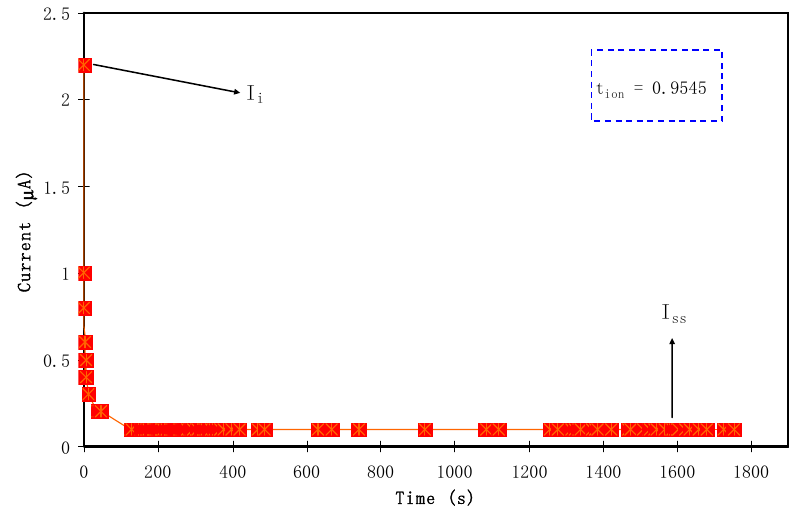
Figure 4. Current with respect to time plot for theCSPX4 blend electrolyte film.